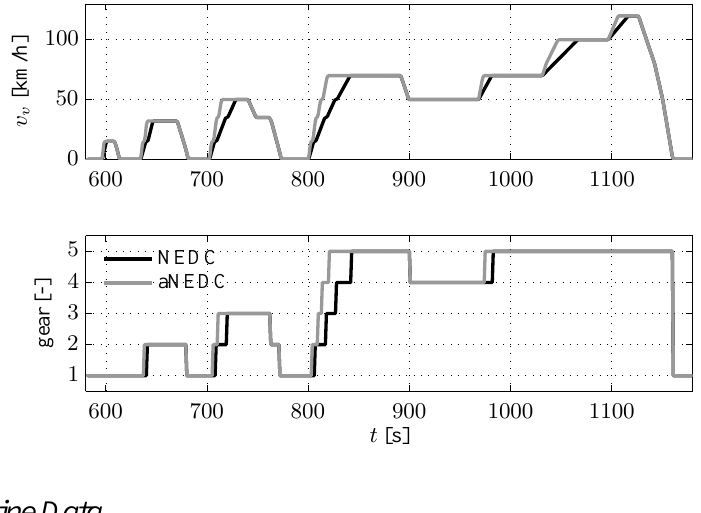
Figure 6. Comparison of velocity v the last part of the ECE and on the EUDC.